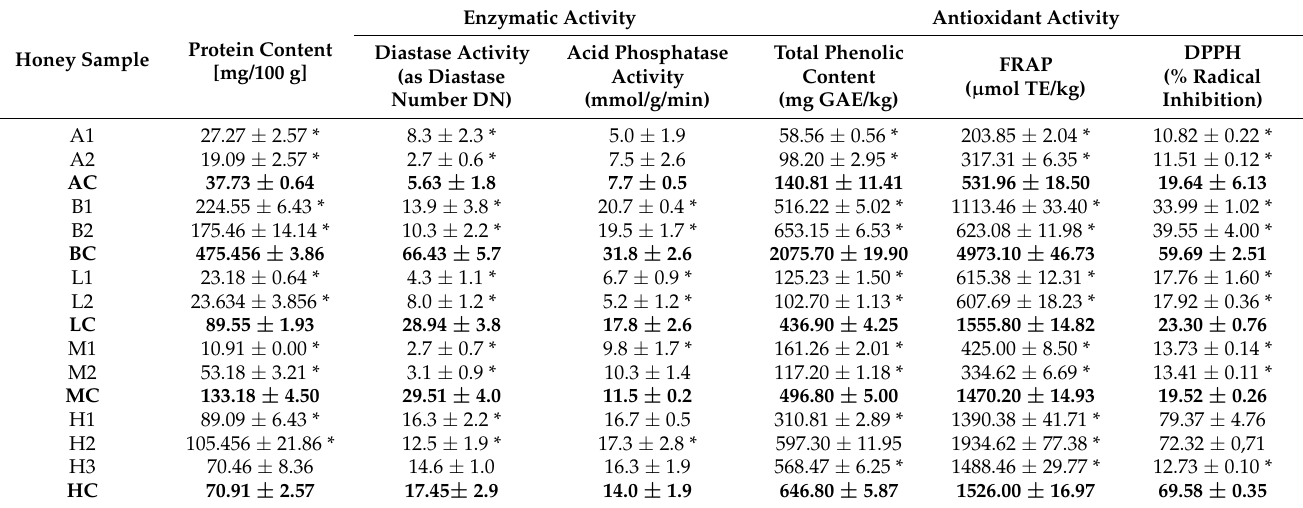
* Means marked with the symbol differ statistically significantly from a high quality local control sample (marked with bold): AC for acacia, BC for buckwheat, LC for linden, MC for multifloral, and HC for honeydew honey ( t -test, p <